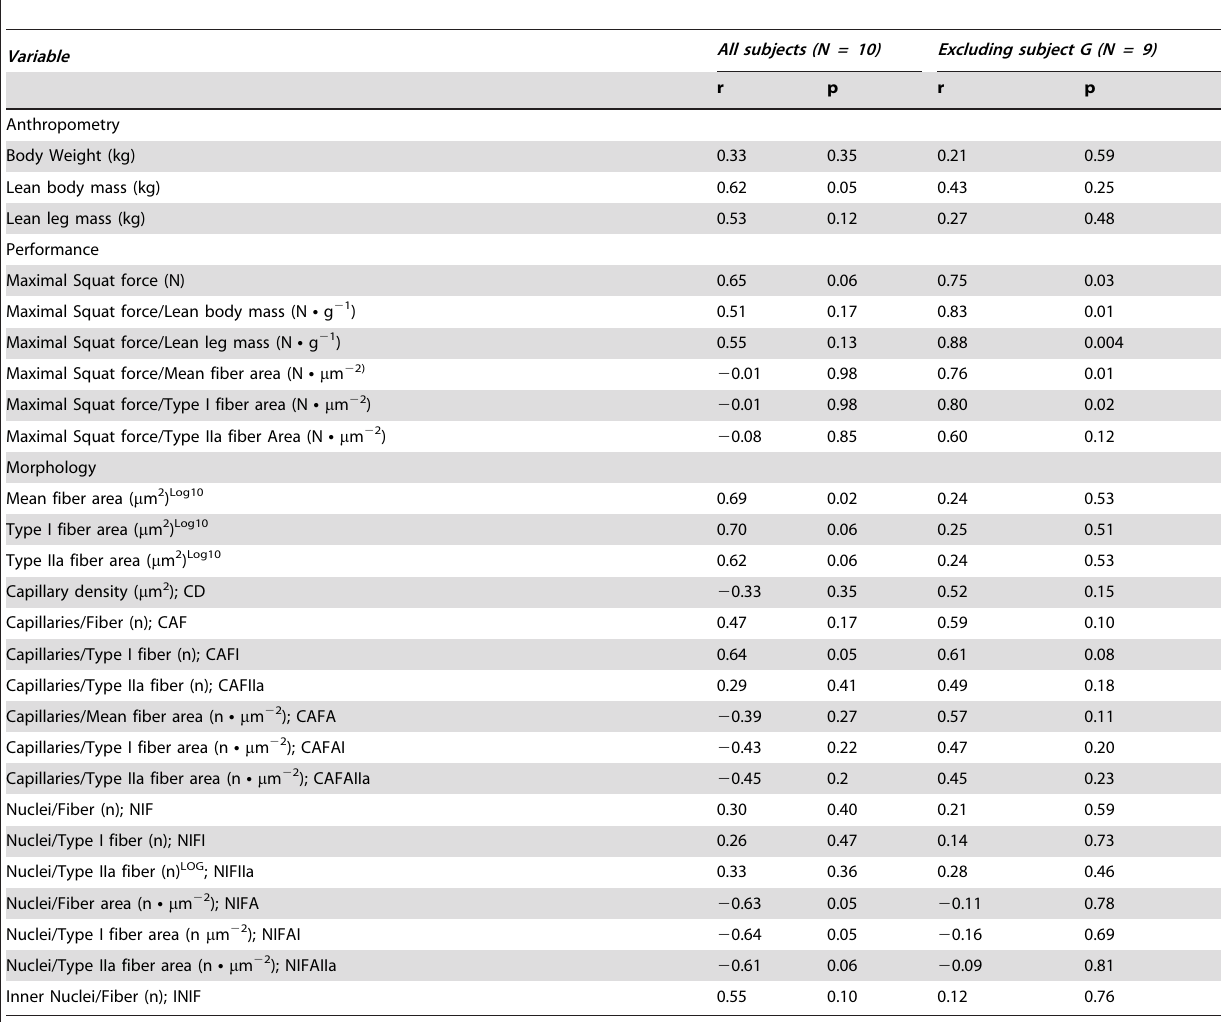
Table 4. Correlations between AAS dosage and measured